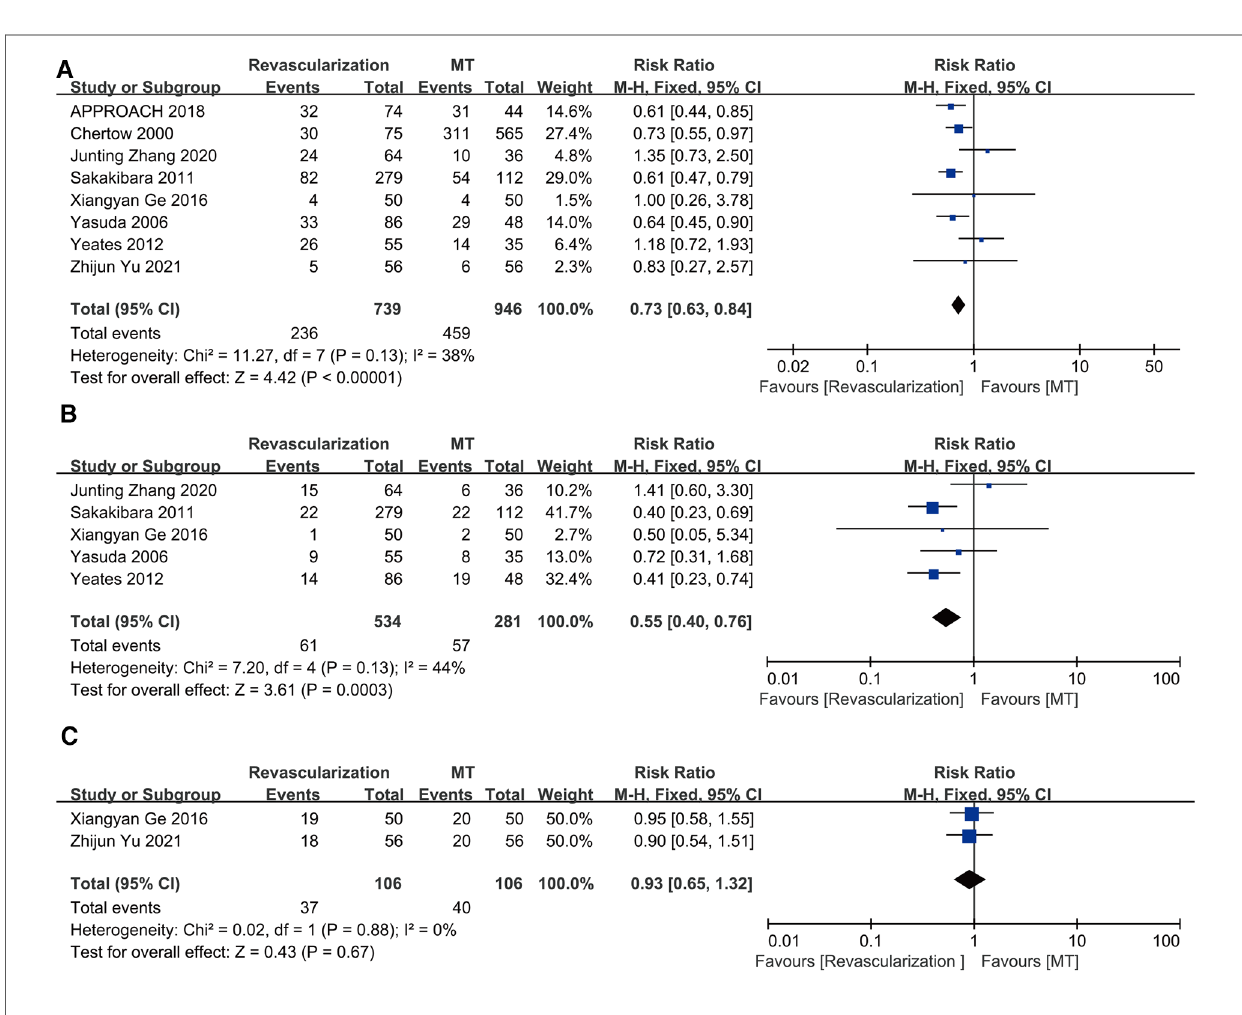
FIGURE 4 Revascularization vs. medical therapy: ( A ) long-term all-cause death; ( B ) long-term cardiac mortality; ( C ) the incidence rate of bleeding events. CABG, coronary artery bypass grafting; CI, con fi dence interval; MT, medical therapy; PCI, percutaneous coronary